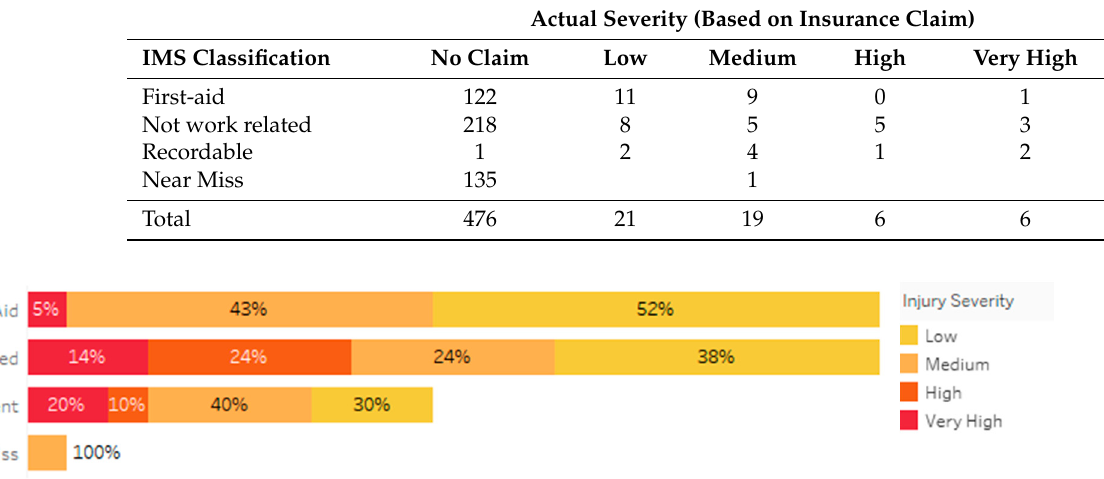
Figure 2. Original incident classifications coloured by actual severity.